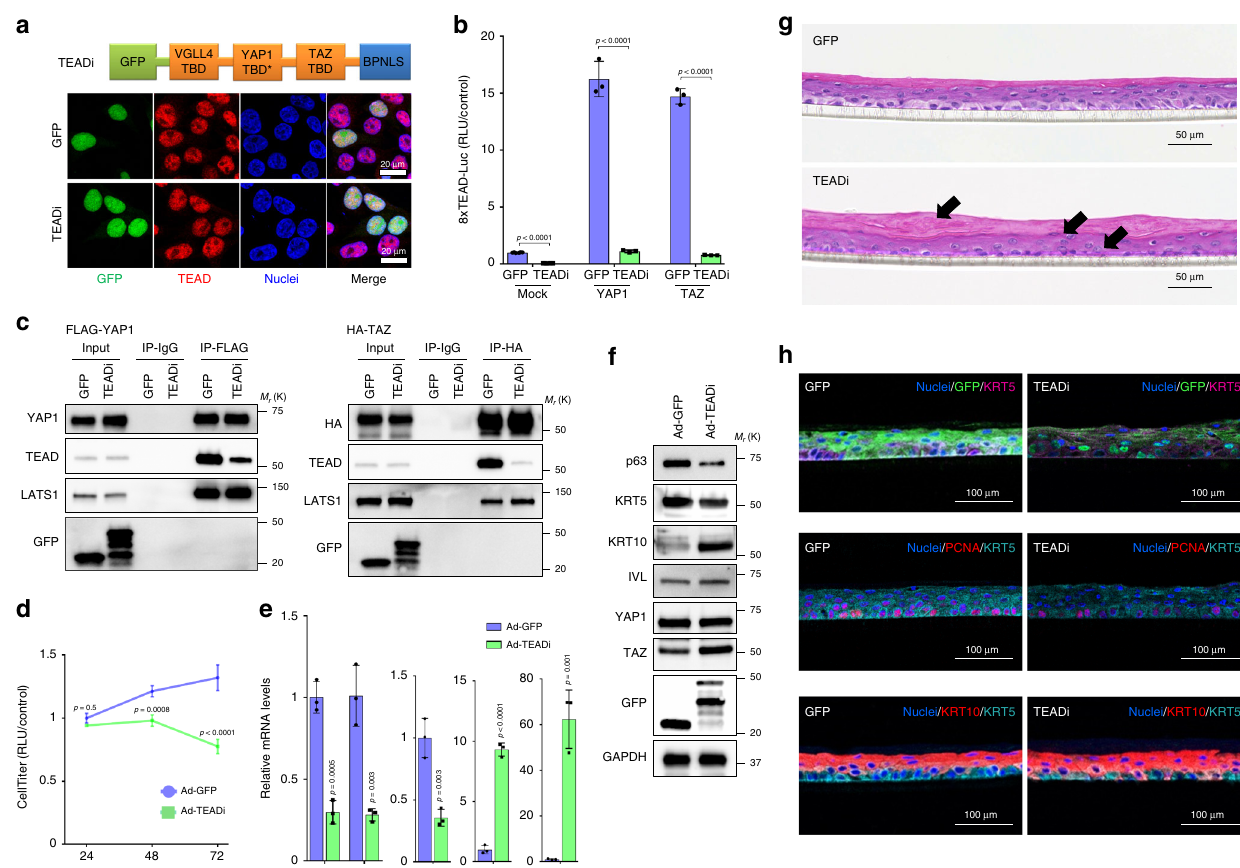
Fig. 1 An inhibitor of the transcriptional activity of TEAD triggers rapid keratinocyte cell cycle arrest and differentiation. a Schematic representation of TEADi and IF showing its nuclear localization in HEK293 cells. b Transcriptional activity of TEAD measured by luciferase assay with a reporter containing tandem TEAD-binding sites in HEK293 cells. c Coimmunoprecipitation experiments in HEK293 cells to show TEADi reduces TEAD interaction with YAP1 and TAZ. d Luminescence cell proliferation assay in N/TERT2G cells transduced with adenoviruses expressing GFP (Ad-GFP, control) or TEADi (Ad- TEADi). e qRT – PCR analysis of expression of indicated markers in N/TERT2G keratinocytes transduced with GFP (Ad-GFP, control) or TEADi (Ad-TEADi) for 48 h. Values are indicated in fold over GFP control. f Western blot analysis of expression of basal and differentiation markers in N/TERT2G cells transduced with GFP (Ad-GFP, control) or TEADi (Ad-TEADi) for 48 h. g Epidermis reconstruction assay with N/TERT2G keratinocytes stably expressing a tetracycline-inducible GFP (control) or TEADi. Arrows indicate aberrant differentiation. h IF staining showing the expression of proliferation and differentiation markers in the organotypic epidermis. In b , mock n = 6, YAP1 n = 3, TAZ = 3 biological replicates each; in d and e n = 3 biological replicates. Mean± SD is shown; in b and e two-tailed unpaired t test used and in d two-way ANOVA with Sidak ’ s multiple comparison test. Source data are provided as a Source Data fi